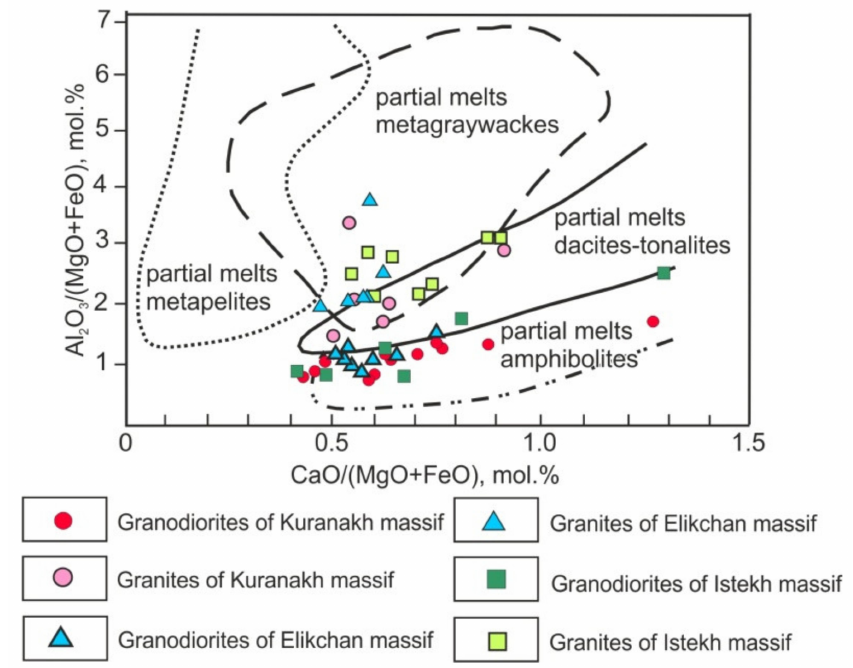
Figure 11. Al/(Mg + Fe) vs. Ca/(Mg + Fe) diagram for granitoids. Fields of magma-generating substrata are derived from [85].